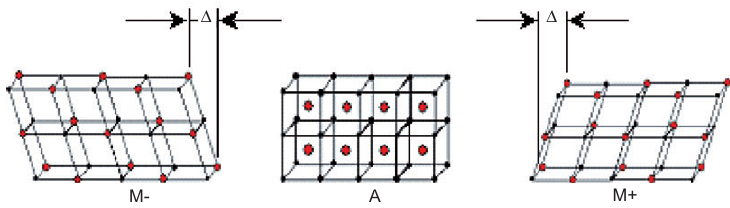
Figure 11 Three configuration of a shape memory alloy lattice particle ( M